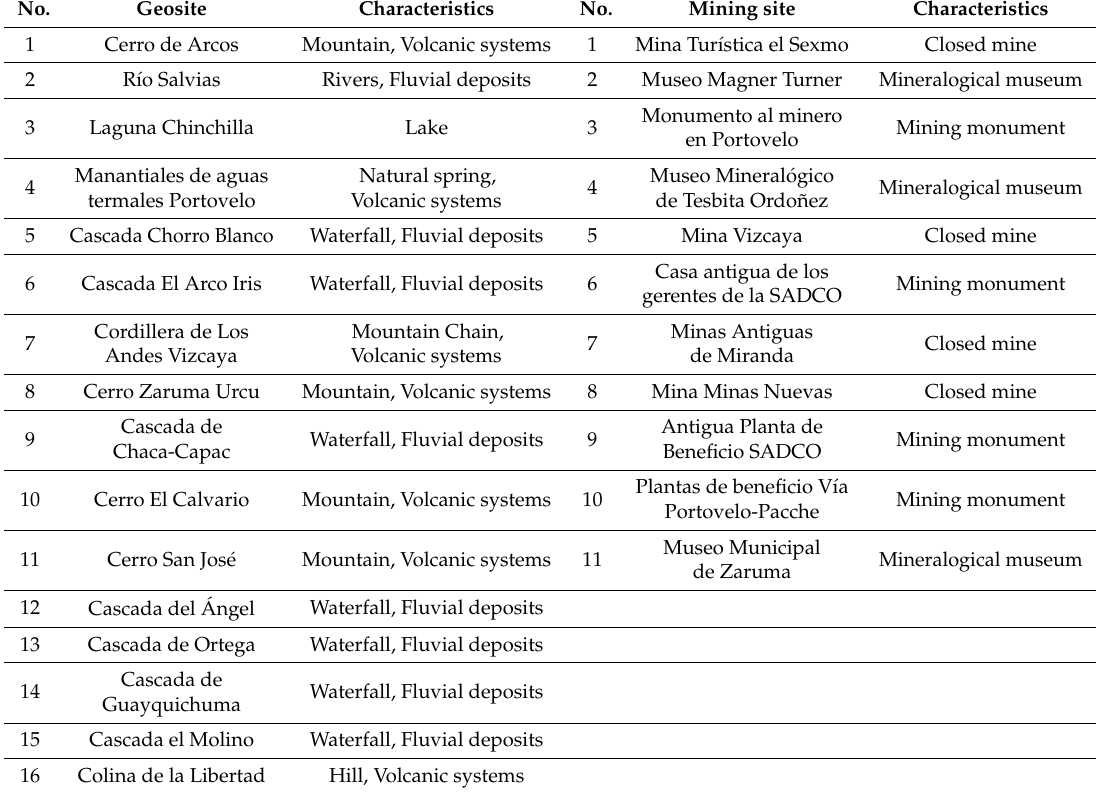
Table 3. List of potential geosites and mining sites identified in the study